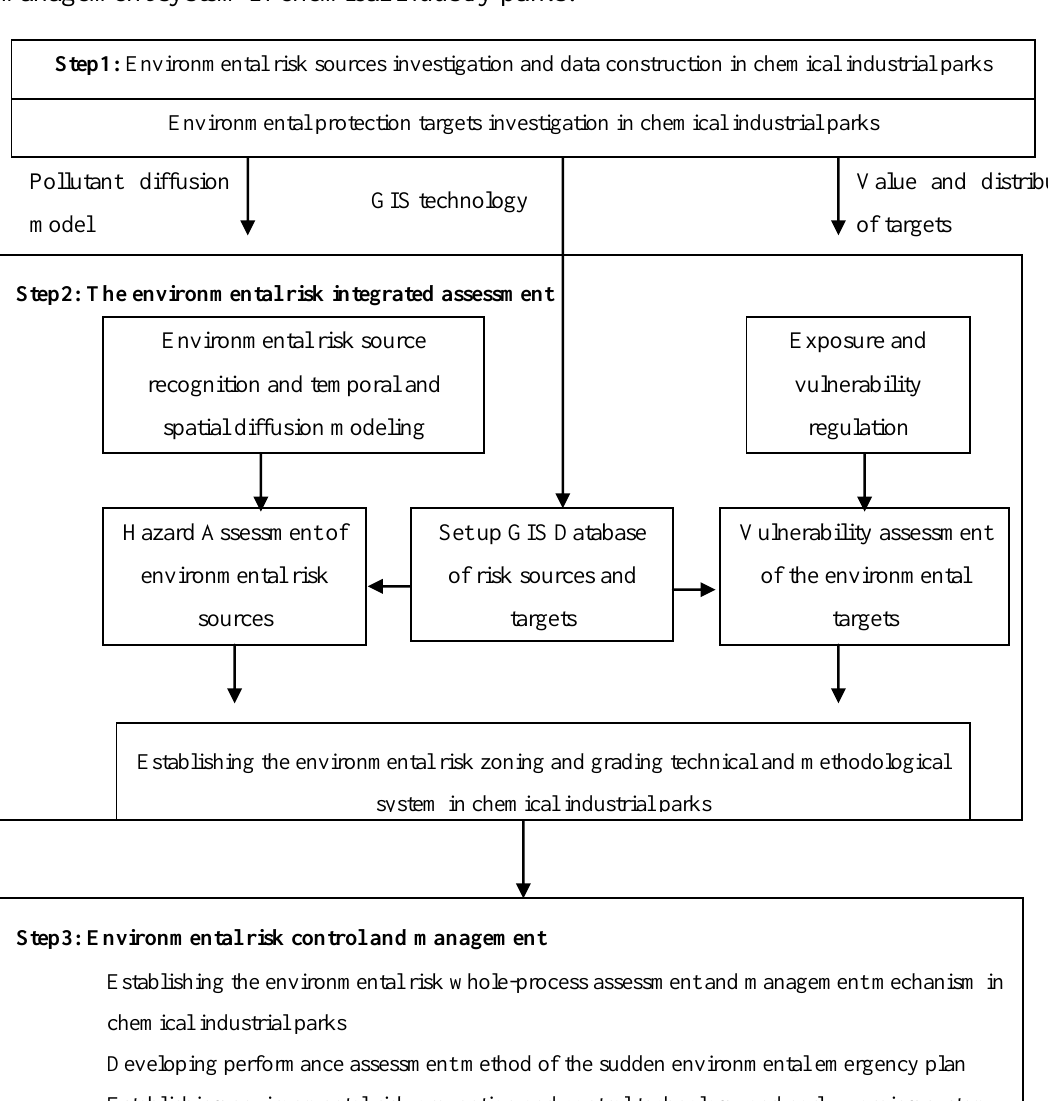
Figure 3. Program design of environmental risk integrated assessment and whole-process management system in chemical industry